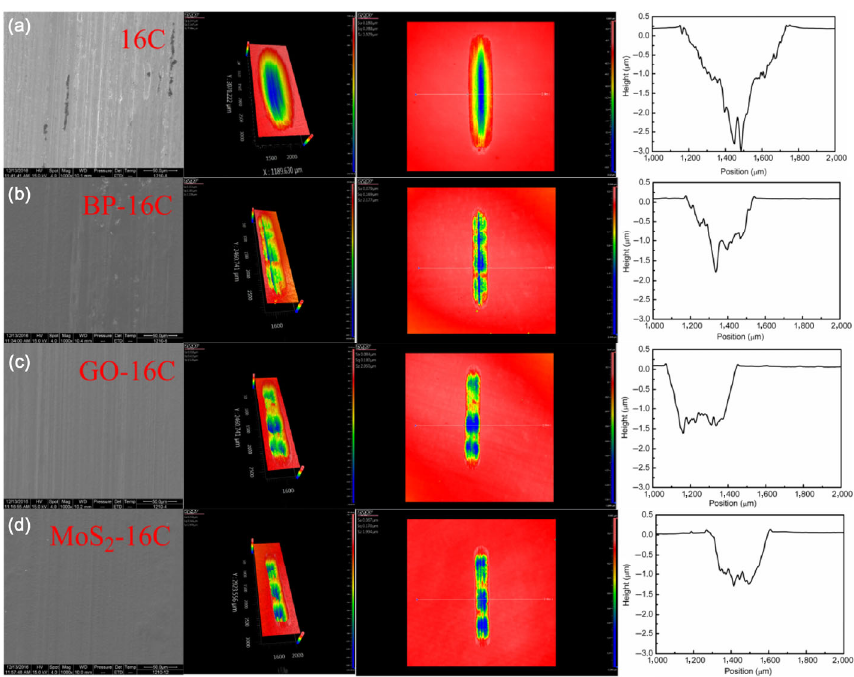
Fig. 13 Wear properties of lower samples (disc) at 70 N: (a) hexadecane; (b) BP diapered in hexadecane; (c) GO diapered in hexadecane; (d) MoS 2 diapered in hexadecane.